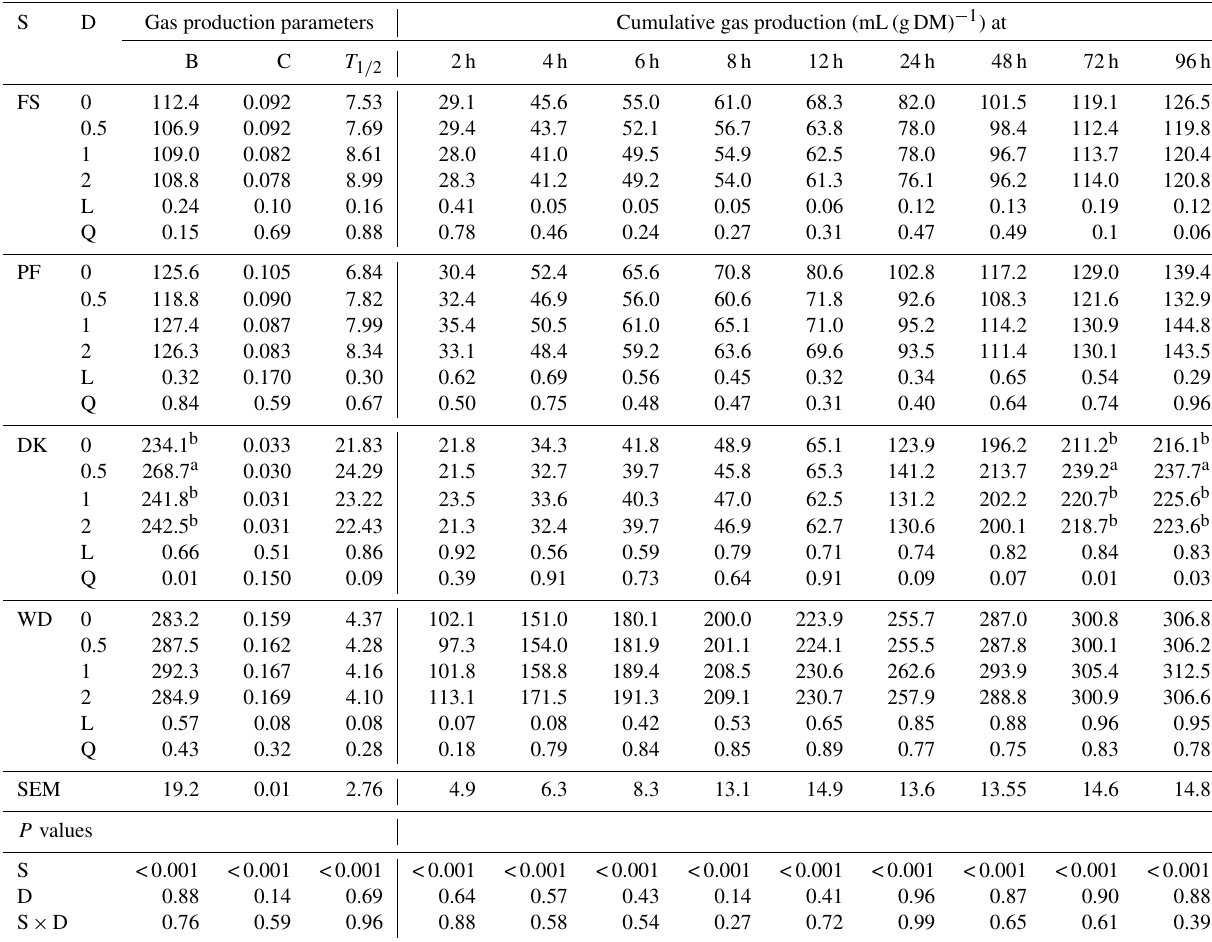
Table 3. Effect of increasing the dose of EFE (mg(gDM) − 1 ) on gas production parameters and cumulative gas production of date palm